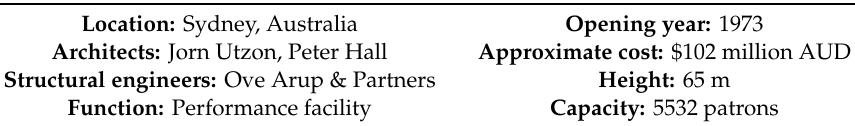
Table 1. Building details of Sydney Opera House